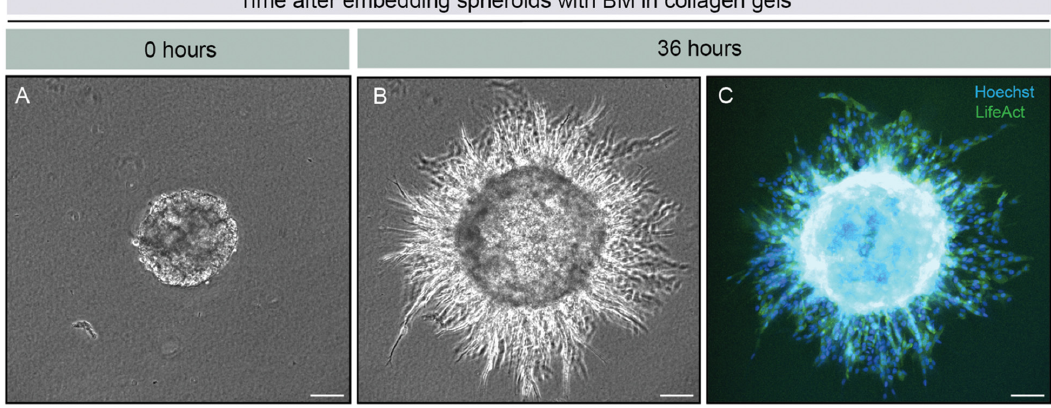
Figure 1. Spheroid invasion through the basement membrane and into a collagen gel. ( A ) Spheroid after embedding in a collagen gel and polymerizing the gel (time 0 h) compared to a spheroid after 36 h ( B , C ). Cancer cells in the spheroid invaded into the surrounding collagen gel and exhibited a “sunburst” phenotype which entails a trail of cells outward from the main spheroid body. We noted that, besides the outward invasion of cancer cells into the collagen gel, the spheroid expanded at 36 h due to ongoing cell proliferation. Scale bars: ( A – C ), 100 µm.